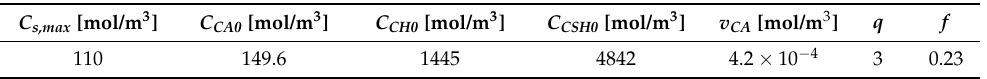
Table 2. Parameters obtained from the experimental data of Xie et al. [11].